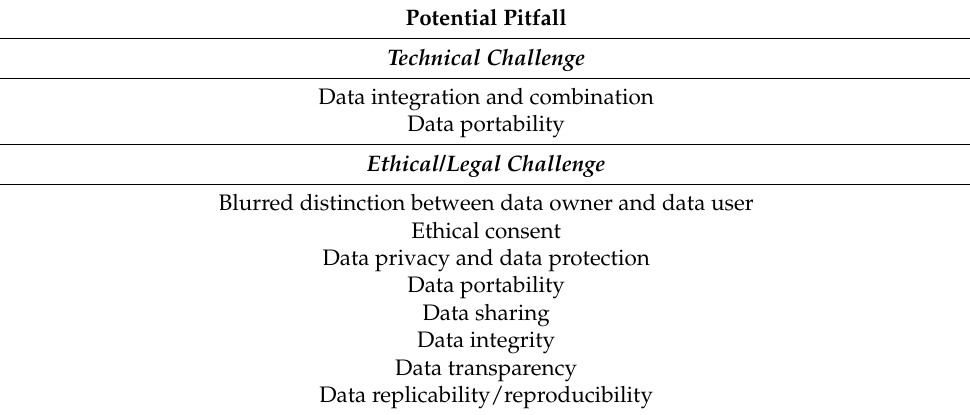
Table 5. The main pitfalls and limitations plaguing the usage of big